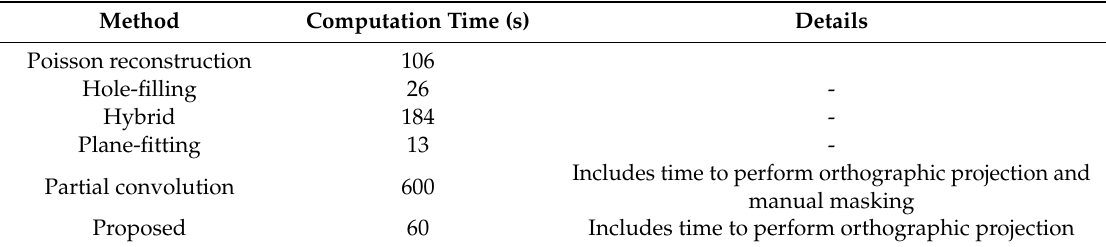
Table 7. Computation time comparison between di ff erent scene completion